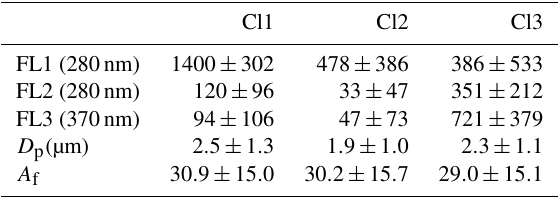
Table 3. Solutions to the Ward linkage cluster analysis, showing mean ( ± 1 standard deviation) intensity in each fluorescence chan- nel (FL1–3), optical particle diameter ( D p ), and asymmetry factor ( A f ). The intensities are referenced to the FT + 3 standard deviation threshold representing an intensity of zero, as discussed is Sect. 2.5. Fluorescent intensities and asymmetry factors are in arbitrary units. Cl1